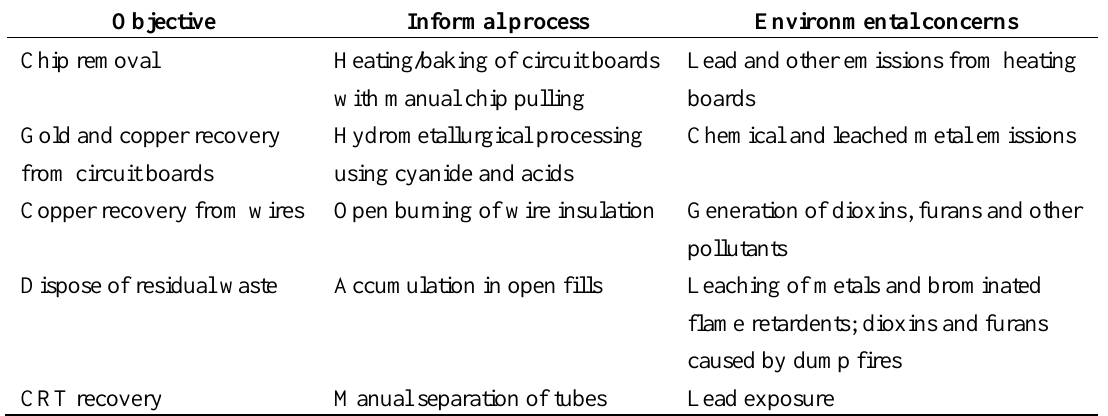
Table 2. Partial list of environmental concerns in informal recycling of electronics (CRT = Cathode Ray